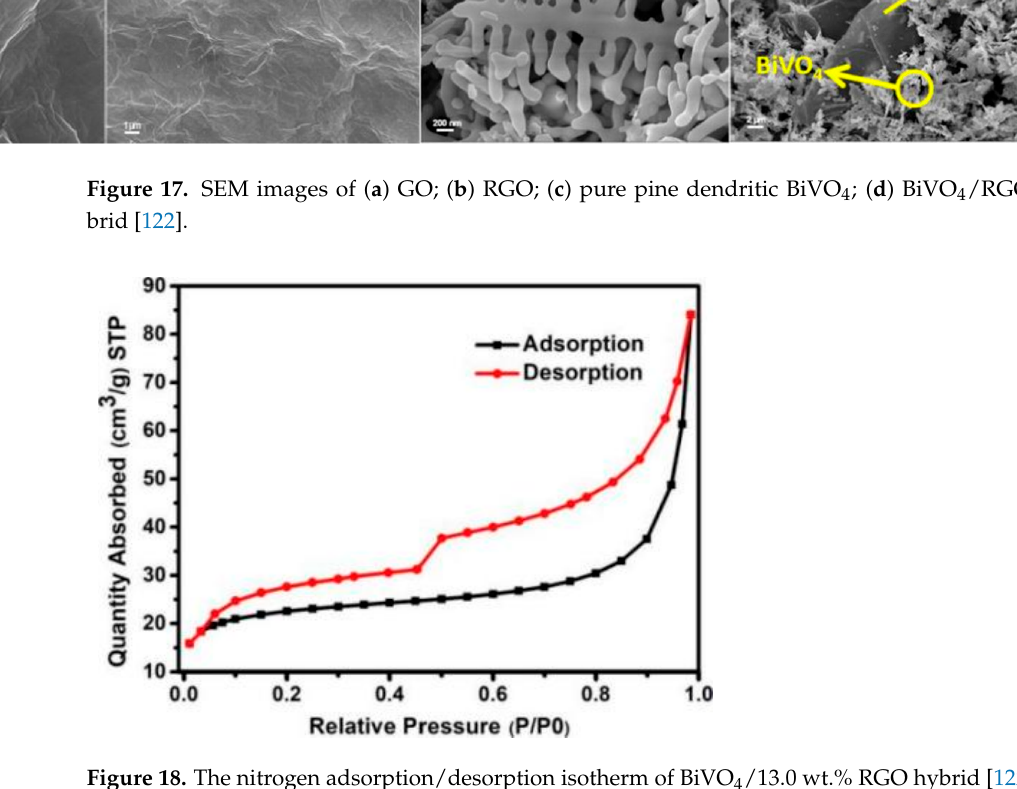
Figure 19. ( a ) Dynamic response–recovery curves (100 ppm TEA) of pure α -Fe 2 O 3 spindles and RGO/ α -Fe 2 O 3 nanocomposites at 280 °C. ( b ) Concentration-dependent response curves of pure α - Fe 2 O 3 spindles and RGO/ α -Fe 2 O 3 nanocomposites to 10–1000 ppm TEA [123]. Yu et al. [124] modified Co 3 O 4 nanoparticles by wrapping RGO via a simple hydro- thermal method. In their experiments, they found that Co 3 O 4 with {100} crystal planes and